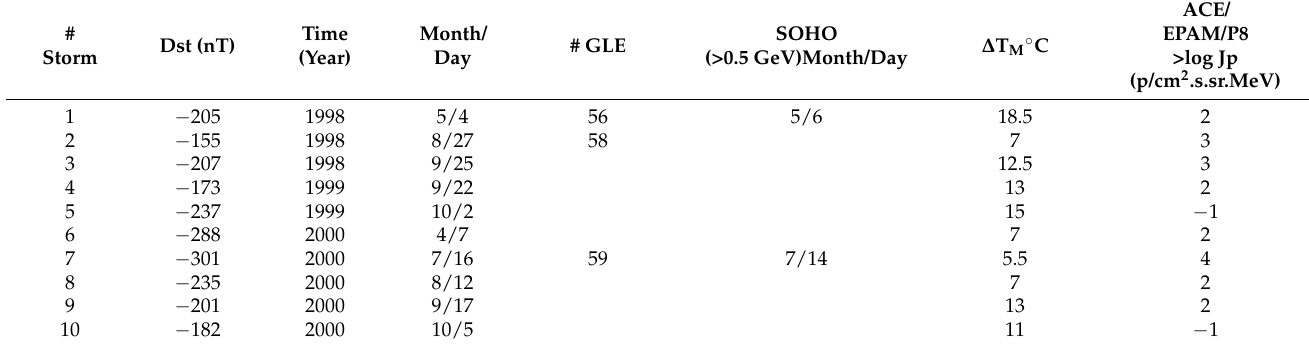
Table A1. Data for strong geomagnetic storms with index Dst ≤ − 150 nT between August 1997 and May 2015, associated Ground-Level Enhancements events, SOHO SEP events with very high- energy ( ≥ 0.5 GeV) proton measurements, and surface air temperature variations (increases) and corresponding time duration, in Madison, Wisconsin, following the onset of storm-related SEP events (see in the